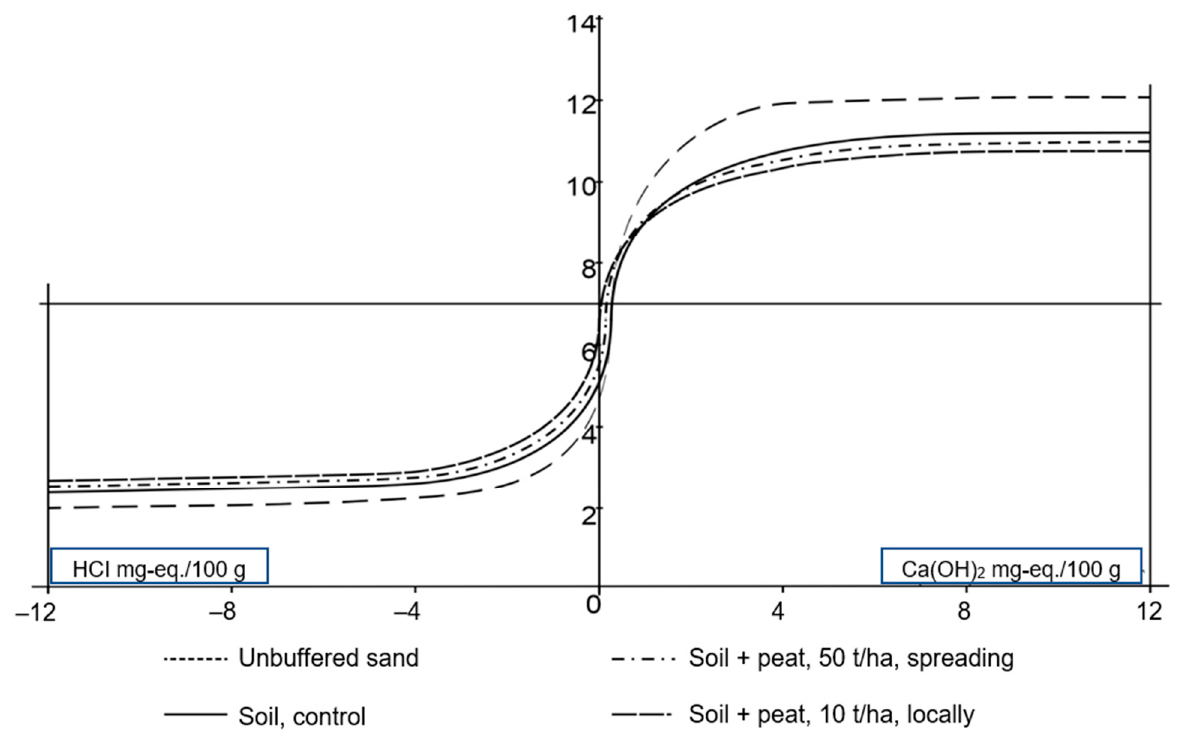
Figure 3. Graphs of pH buffering of sod-podzolic cohesive sandy soil depending on the method of applying doses of clay. Source: authors’ research results.